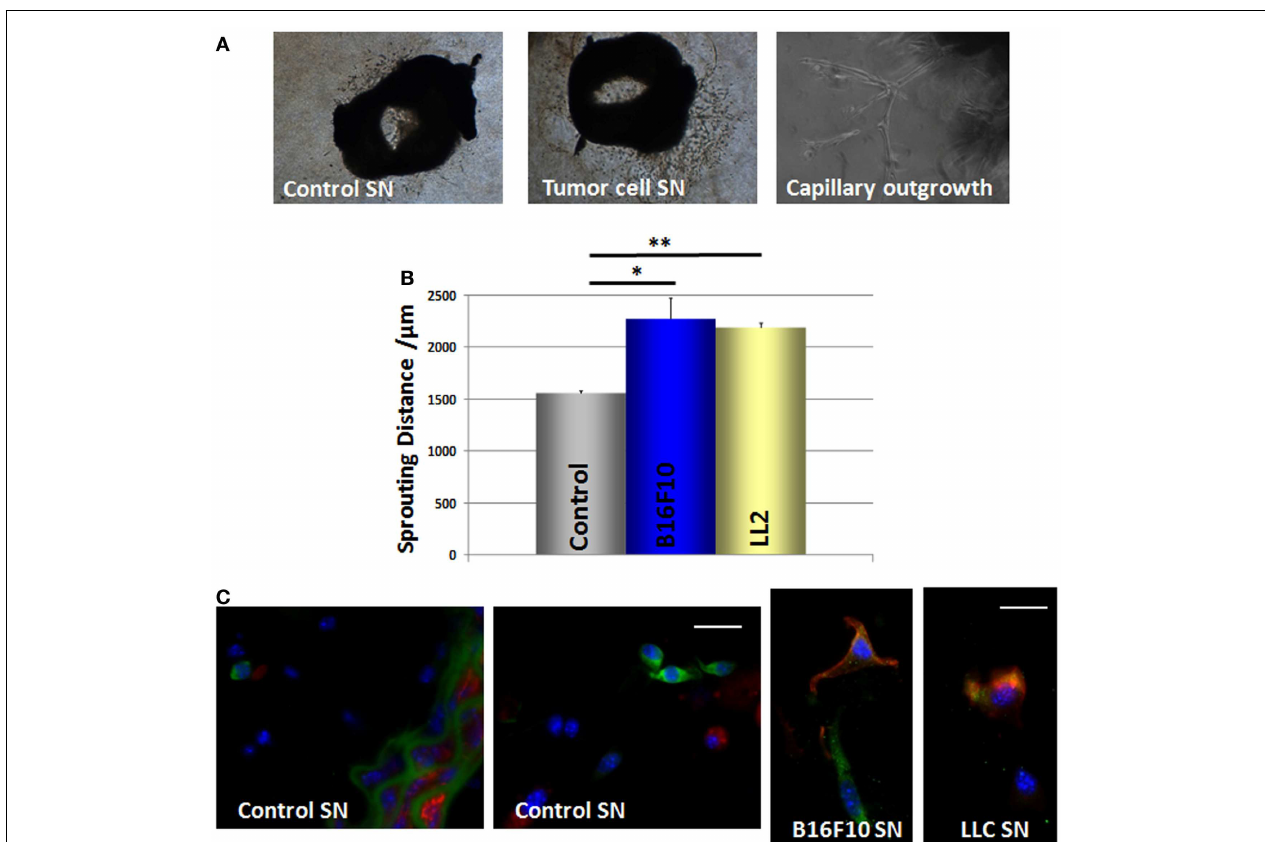
microscopy for 14days. (B) The distance of capillary-like sprouts was measured to quantify the invasion. Data are presented as mean ± SD from four independent experiments measured at least two times each. * p ≤ 0.05; ** p ≤ 0.005. (C) Collagen gels were fixed, paraffin embedded, and tissue sections were subjected for immunofluorescence using antibodies against GFP (green) and SMA (red). Scale bar 10 µ